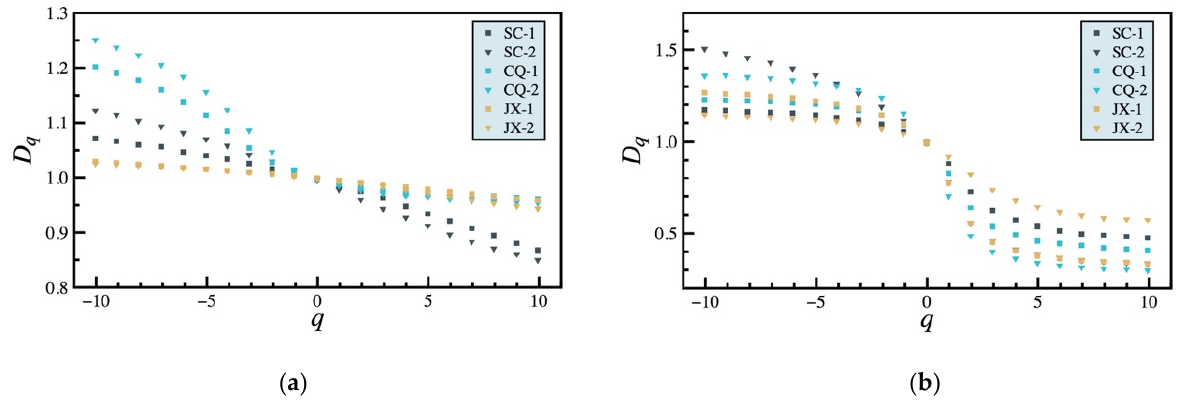
Figure 4. Generalized fractal spectra of shale pores: ( a ) organic pores, ( b ) inorganic pores.